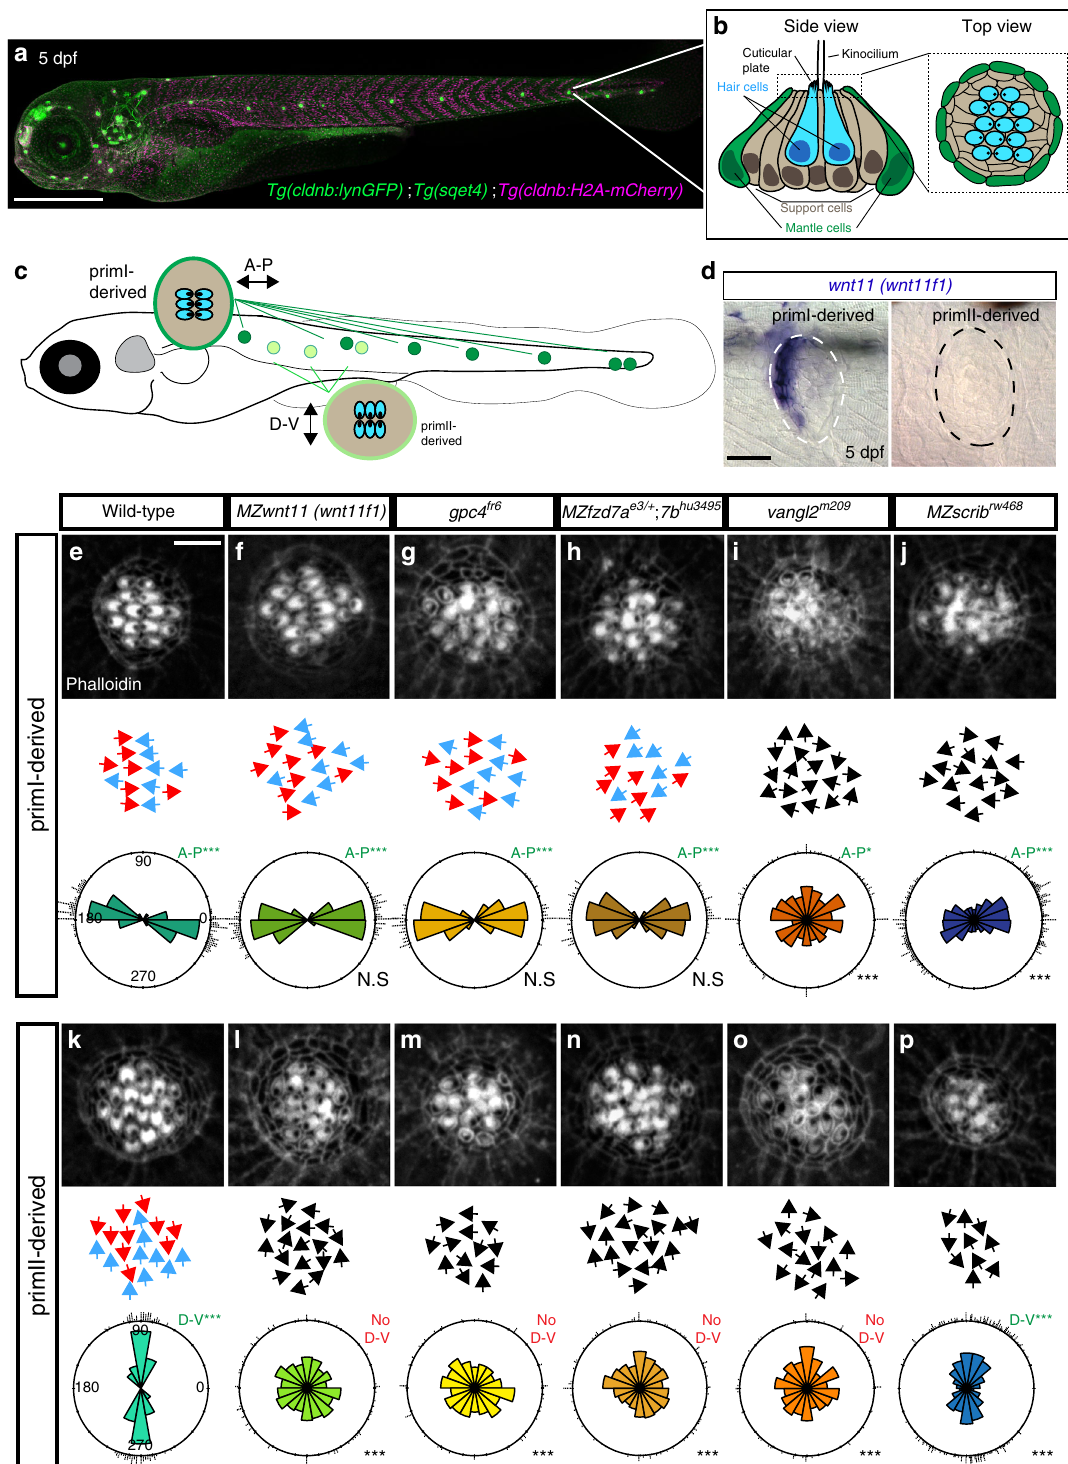
single mutants (Supplementary Fig. 1o). gpc4 and fzd7a/7b also interact with wnt11f2 (formerly called wnt11/silberblick , 40 ) during CE 18,50,51 . We, therefore, wondered if wnt11f2 mutants also possess hair cell defects and if wnt11f2 possibly interacts with wnt11 (wnt11f1) . However, wnt11f2 mutants have normal hair cell orientations, as do wnt11 (wnt11f1);wnt11f2 double hetero- zygous animals, indicating that these two paralogs do not interact (Supplementary Fig.